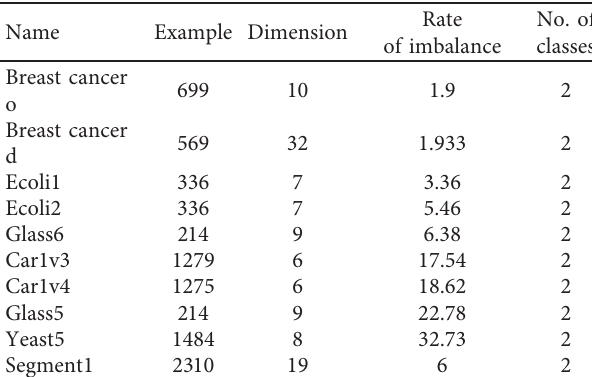
Table 2: Descriptions of the experimental